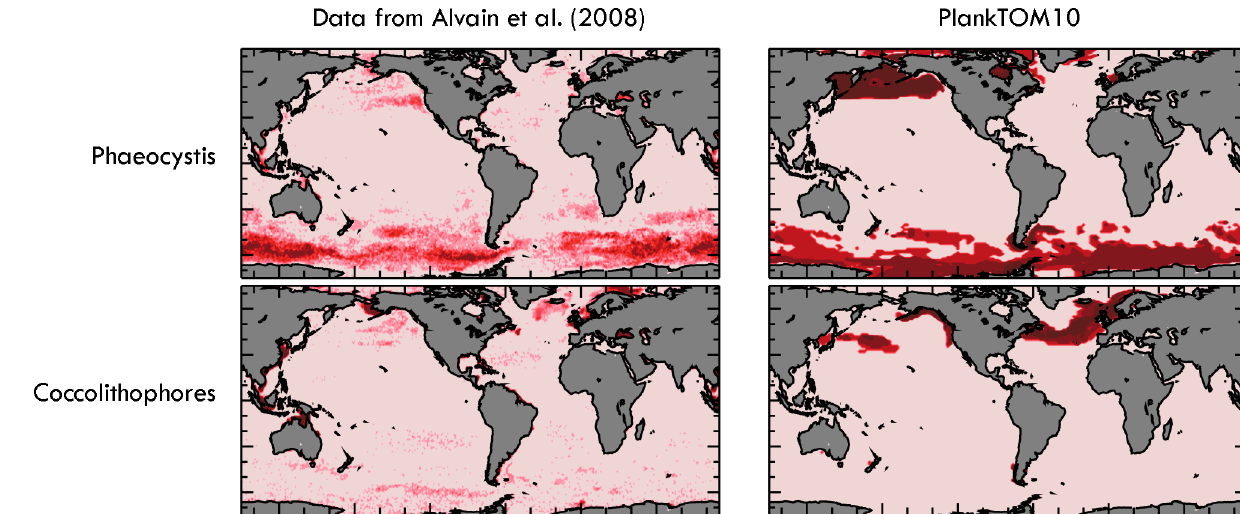
Figure 7. Frequency of blooms of Phaeocystis (top) and coccolithophores (bottom) in the surface ocean. Phaeocystis data are from Alvain et al. (2005); coccolithophore blooms are updated from Brown and Yoder (1994). A bloom is defined in the model when the PFT accounts for at least 30% of the biomass and when Chl exceeds 0.3mgChlm − 3 . The dark red represents the area with highest dominance of a PFT, while in the lightest red the PFT is